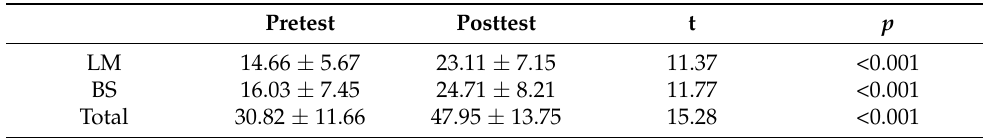
Table 1. Efficacy of CHAMP intervention across TGMD